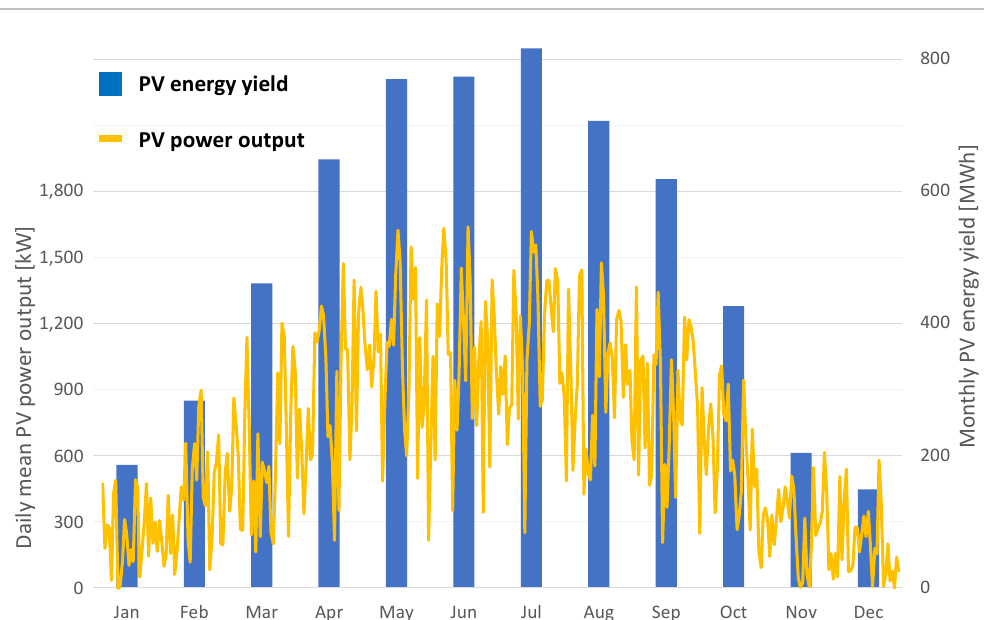
Figure 8. Monthly PV energy yield (blue = SimStadt simulation results) and daily mean PV power output (yellow = via INSEL PV load profile) for Walheim.